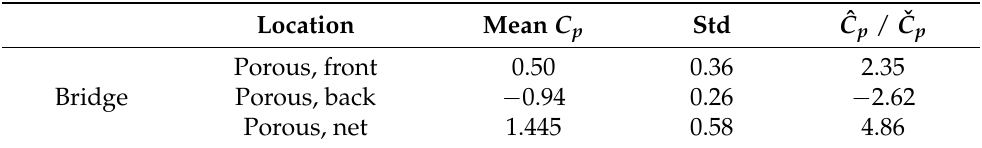
Figure 15. Time domain comparison between the pressure signals acquired by the pressure taps on the bridge: the plot on the left plot shows a snapshot of the time histories, while plot on the right shows the location of the pressure taps along with the incoming flow direction. Table 3. Pressure taps statistics, wind direction −